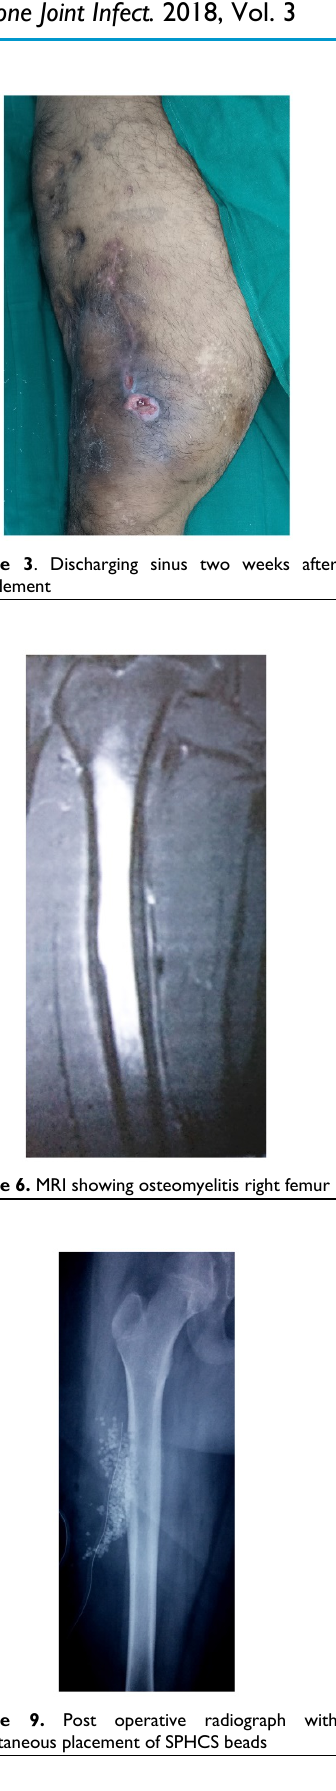
http://www.jbji.net